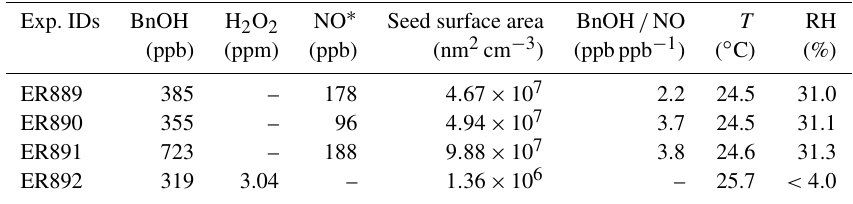
Table 1. Initial conditions for BnOH experiments in the presence and absence of NO. Exp.